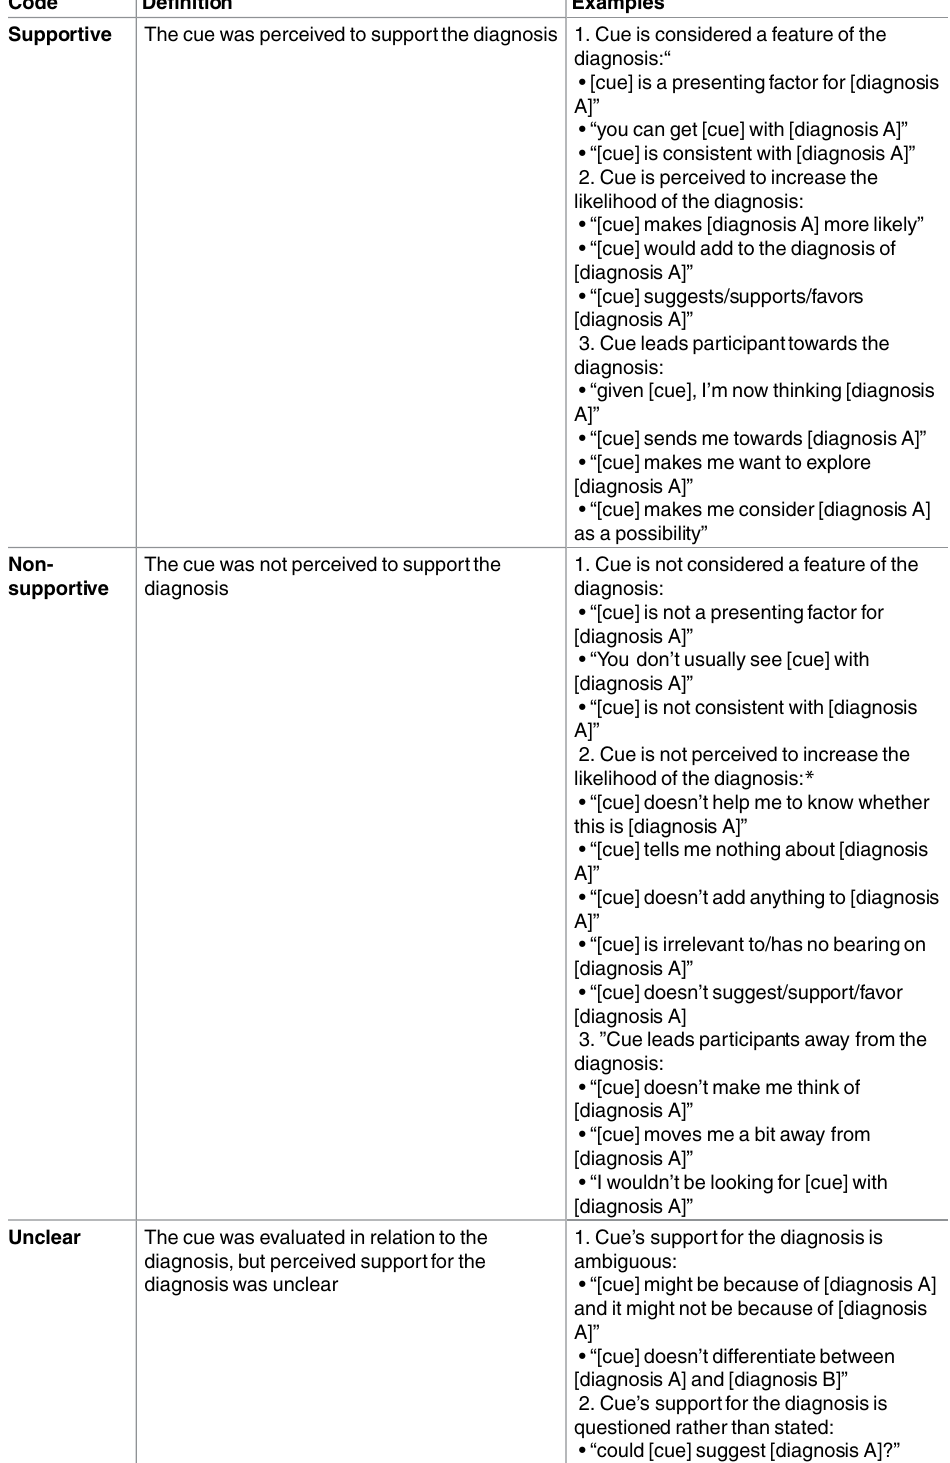
Table 1. Codingscheme for